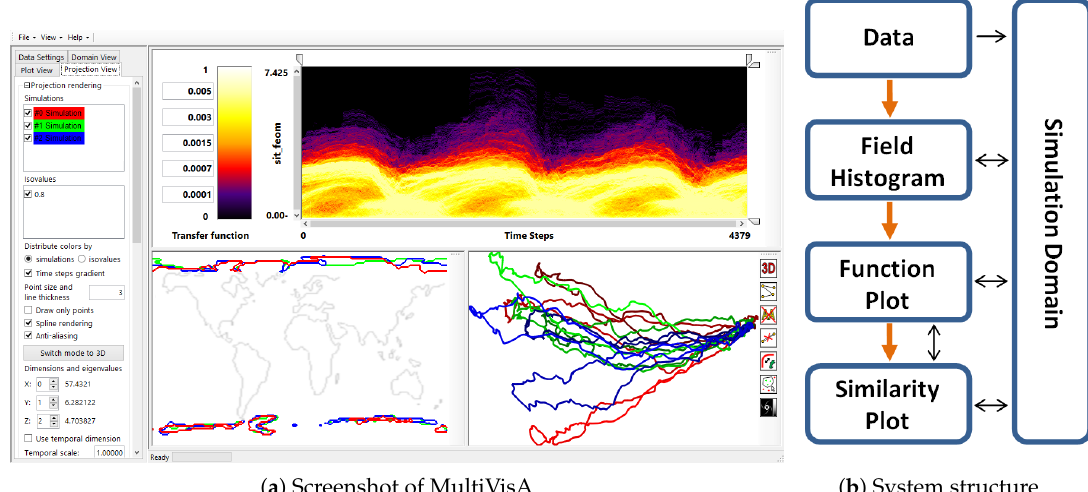
Figure 1. ( a ) MultiVisA: Interactive visual analysis system for physical simulations: ( left ) interaction panel for options and data settings; ( top middle ) transfer function used for function plots; ( top right ) plot view used for field distribution histograms or function plots; ( bottom right ) similarity plot; ( bottom middle ) domain visualization. ( b ) System structure: orange arrows show analysis pipeline, black arrows show possible interactions between different